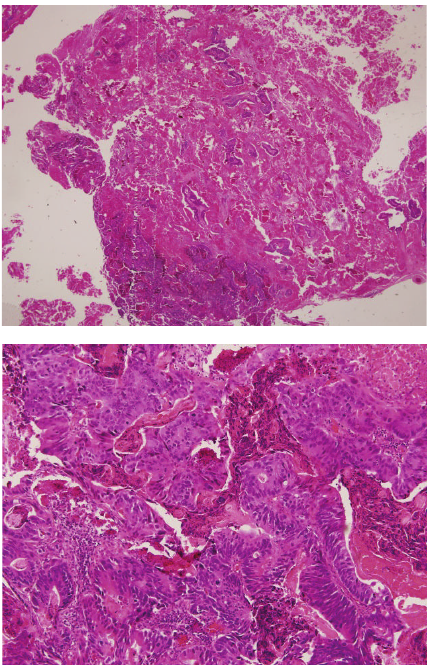
Figure 4: Advanced metastatic adenocarcinoma with focal haem- orrhage and palisading glands with papillary